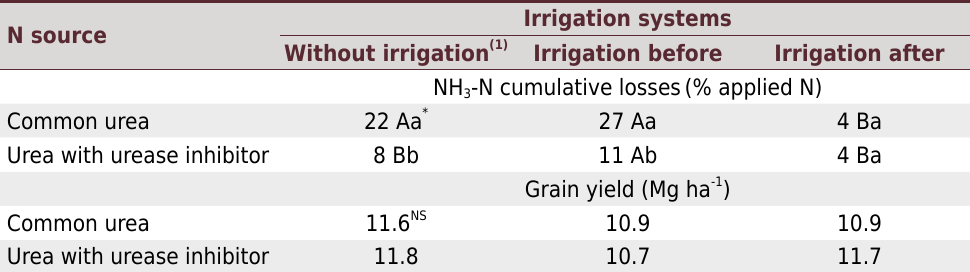
(1) Without irrigation: the plots were protected from rain and dew on the day of fertilization and for 7 days after topdressing N fertilization. Irrigation before: 20 mm water immediately before N fertilization. Irrigation after: 20 mm water immediately after N fertilization. * Different letters indicate that the means of the treatment were different as per Tukey’s test at the 5 % level. Uppercase letters compare irrigation regimes for the same N source (in the line) and lowercase letters compare N sources for the same irrigation regime (in the column). NS: not significant. Note: Corn yield in the control treatment was 8.9 Mg ha -1